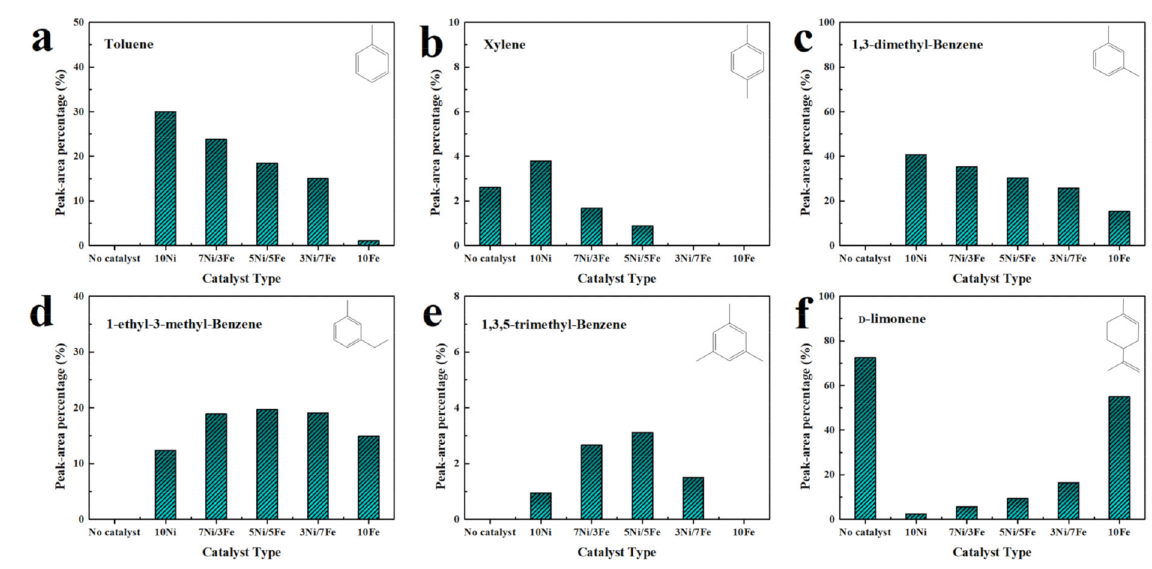
Figure 9. Main chemical compounds obtained from catalytic pyrolysis of waste tire over different catalysts ( a ) Toluene; ( b ) Xylene; ( c ) 1,3-dimethyl-benzene; ( d ) 1-ethyl-3-methyl-benzene; ( e ) 1,3,5-trimethyl-benzene; ( f ) D